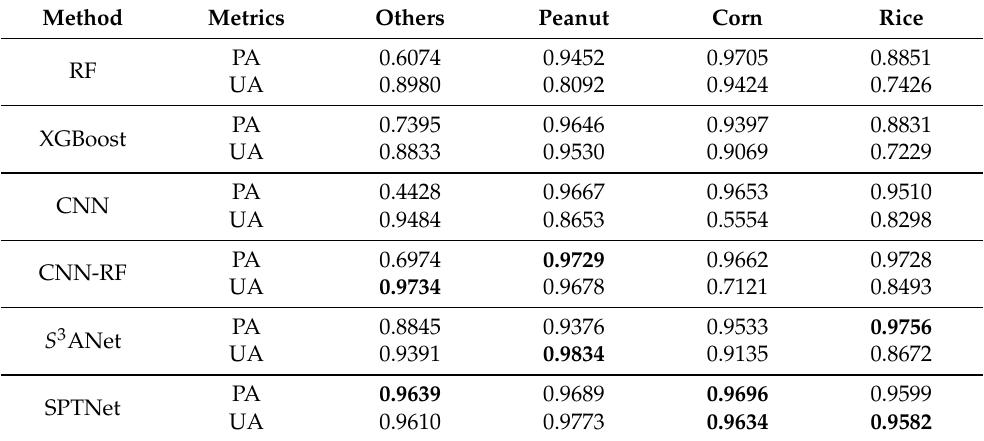
Table 5. The quantitative comparison between the proposed method and the mainstream method in the PA and UA values. The optimal accuracy is